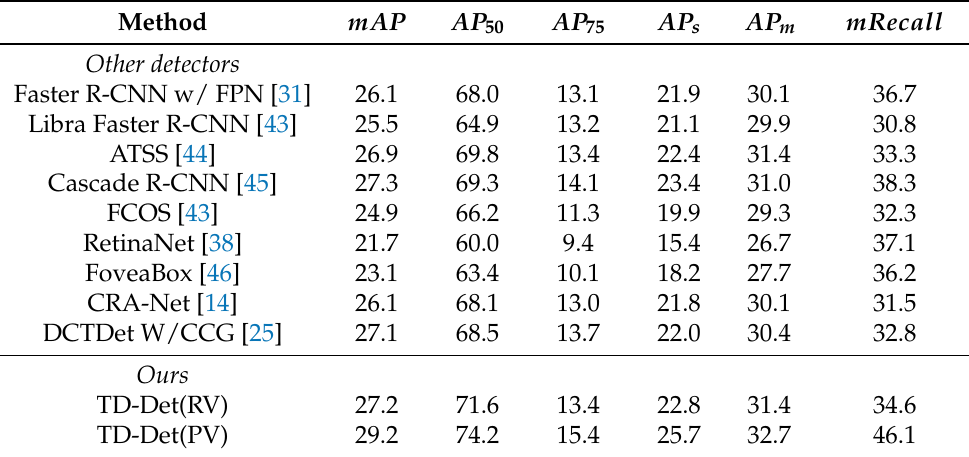
Table 2. Overall performance comparison.